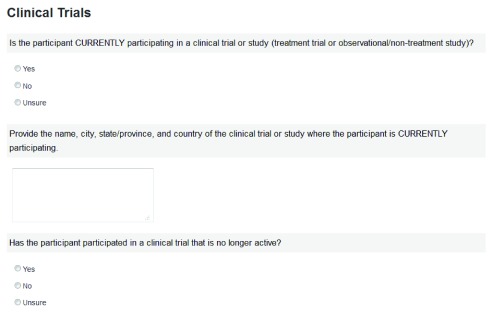
Clinical trials.